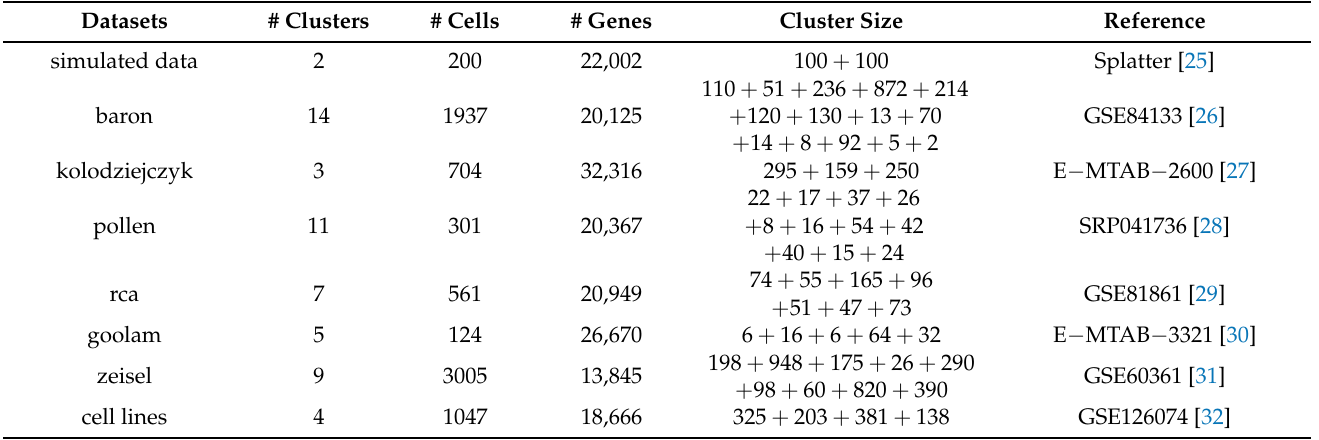
Table 1. A summary of the scRNA-seq datasets used in this